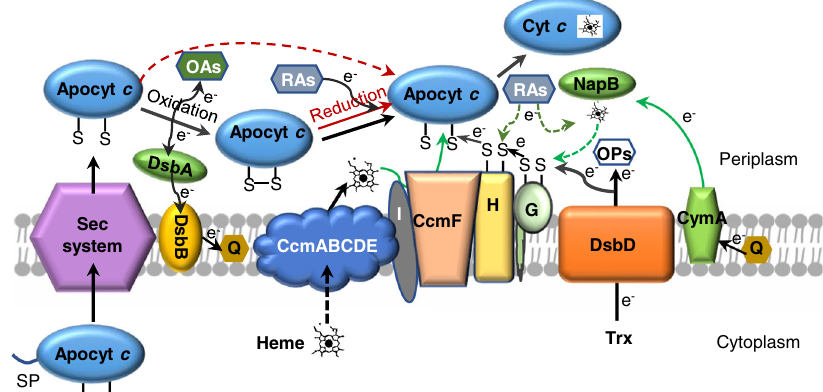
Fig. 1 Proposed model for CCM in S. oneidensis . The model illustrates oxidation and reduction of apocyts c . In S. oneidensis , a large majority of apocyts c can be oxidized by DsbA proteins and by oxidative agents (OAs). These oxidized apocyts c rely on reducing equivalents from DsbD via CcmG and CcmH for their reduction such that covalent heme ligation could occur on CcmF. A residual quantity of reduced apocyts c (red dash line) can be matured by the CCM system without needing electrons from DsbD. In the absence of DsbD, NapB can donate electrons to CcmG for reduction of the oxidized apocyts c . Reducing agents (RAs) may prevent oxidation of apocyts c (red dash line) or reduce oxidized apocyts c (red solid line). RAs may also donate electrons to CcmH and/or NapB (dark green dash lines). Q quinol species, SP signal peptide, OPs other